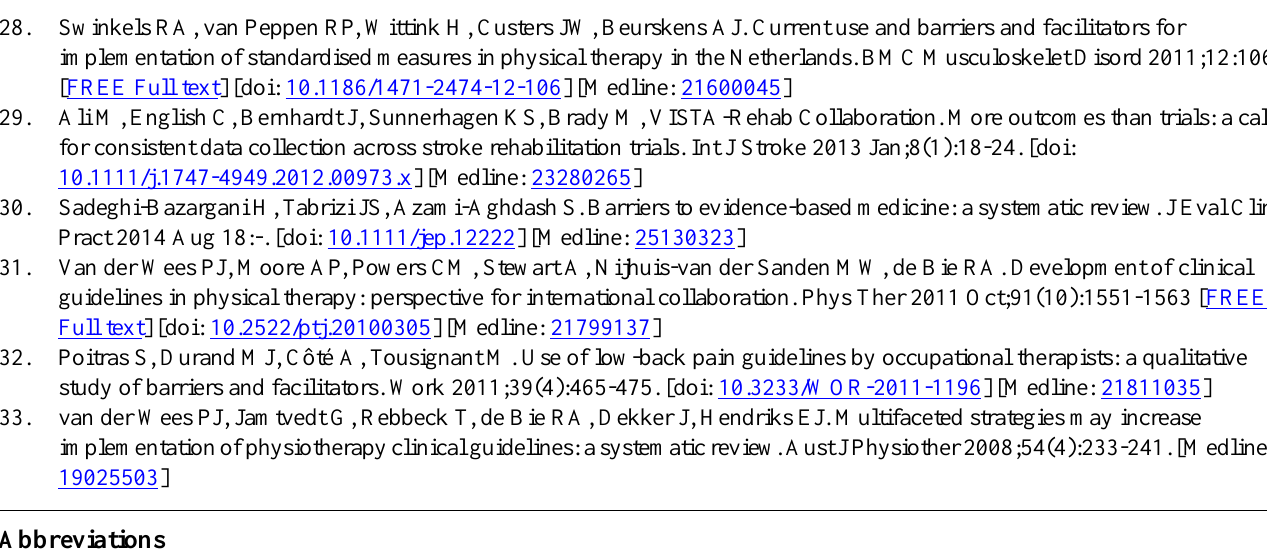
SCI: Spinal cord